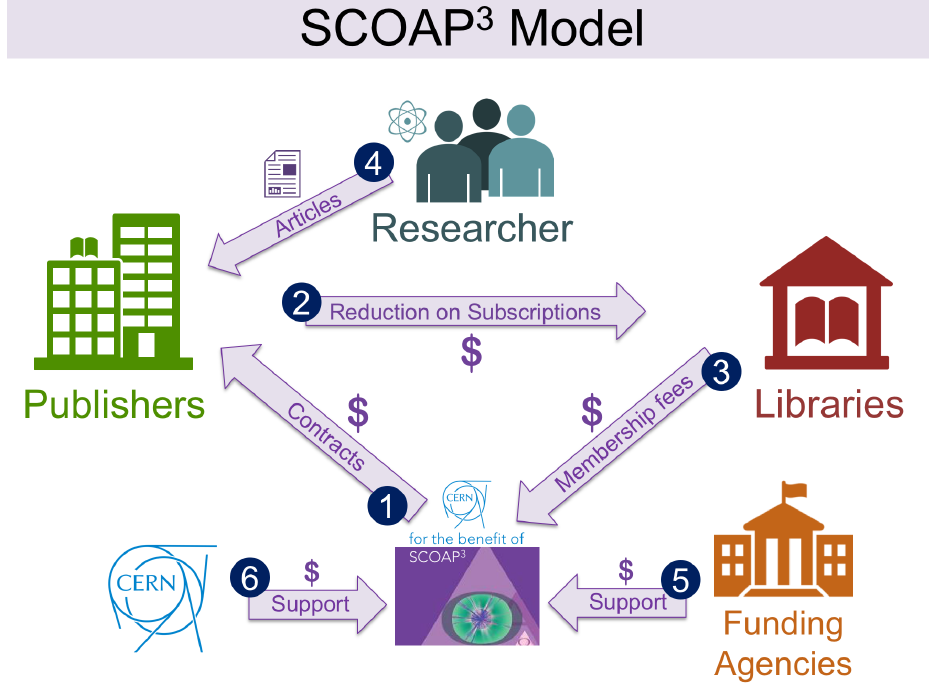
Figure 1. Main stakeholders and financial flows in the SCOAP3 Business